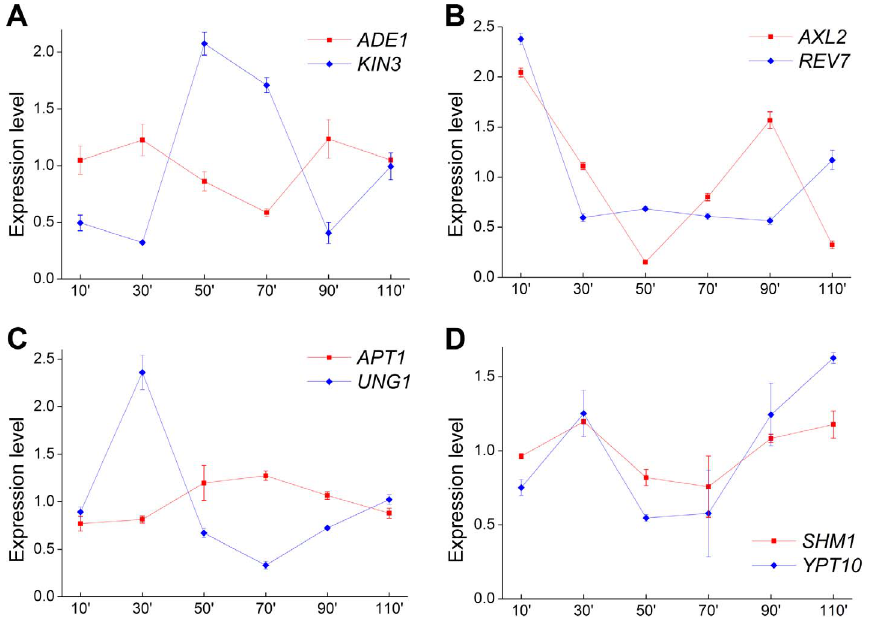
Figure 4. Expression patterns of four convergent gene pairs during the yeast cell cycle. Expression of four pairs of yeast convergent genes with overlapping 3 9 -UTRs in cells from the wild type strain YL1A, the a-mating strain of YL1C ( A ADE1/KIN3 , B AXL2/REV7 , C APT1/UNG1 and D SHM1/ YPT10 ). Gene expression was assessed 10 minutes from the start of the cell-cycle and at 20 minutes intervals thereafter.